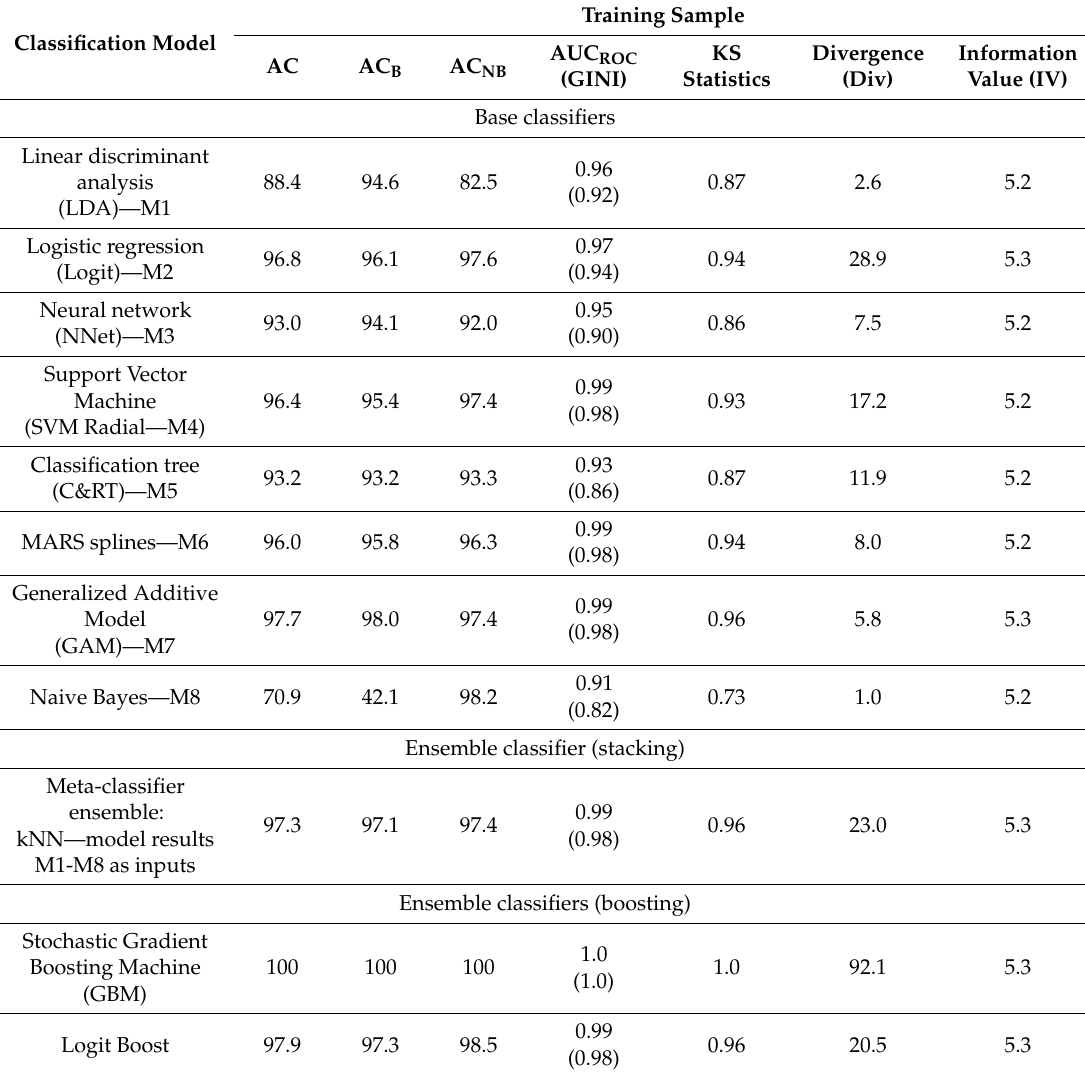
Table A2. Validation statistics for selected classical models of single bankruptcy classifiers in comparison to ensemble classifiers applied for the training